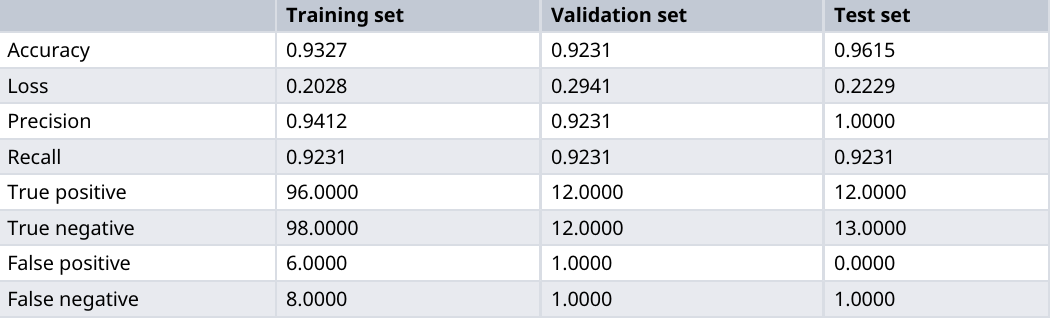
Table 3. Performance of fine-tuned